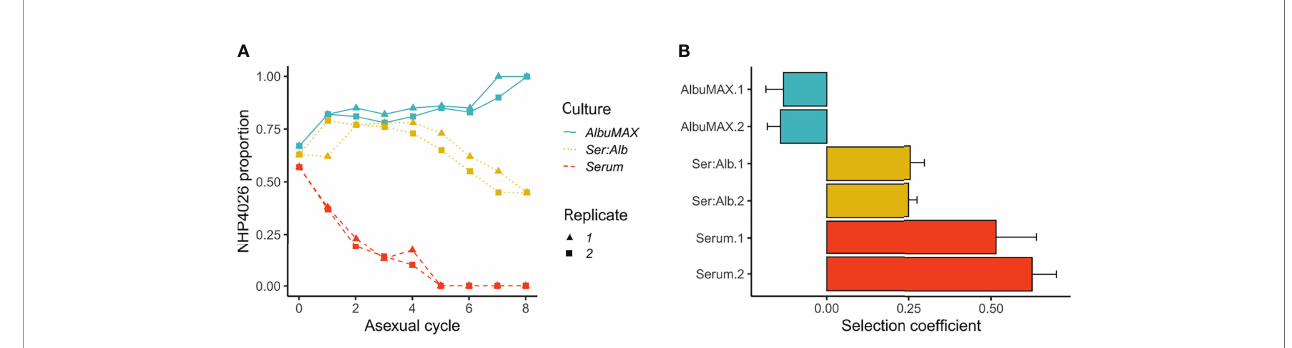
FIGURE 1 | Outcome of competition between 3D7 and NHP4026 under different culture conditions. (A) . Proportion of NHP4026 at each parasite asexual cycle. (B) . NHP4026 selection coef fi cients ( s ) with 1× standard error. Positive s values indicate a disadvantage for alleles inherited from NHP4026. Culture conditions: AlbuMAX, medium contained only AlbuMAX; Ser:Alb, medium contained serum and AlbuMAX at a 50:50 ratio; Serum, culture medium contained only